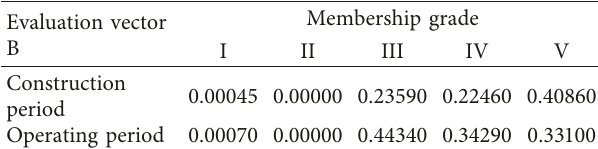
Table 8: Corresponding relationship between fuzzy evaluation vectors and grade of